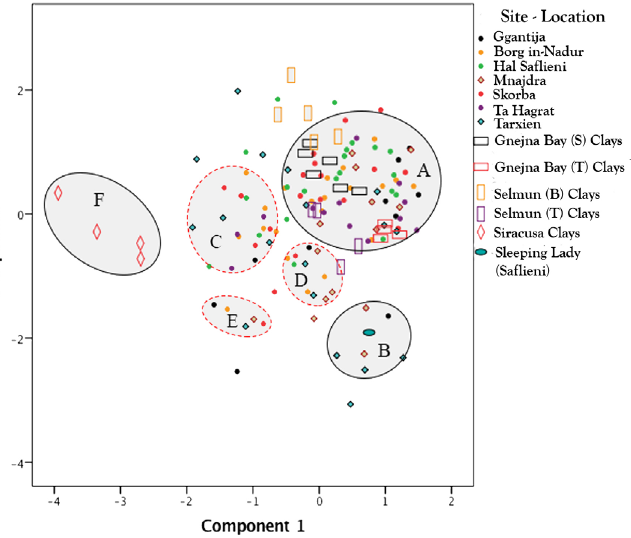
Figure 4. Bivariate scatterplots of principal component scores for Tarxien phase samples and Maltese and Sicilian clay samples. Ellipses are made artificially.